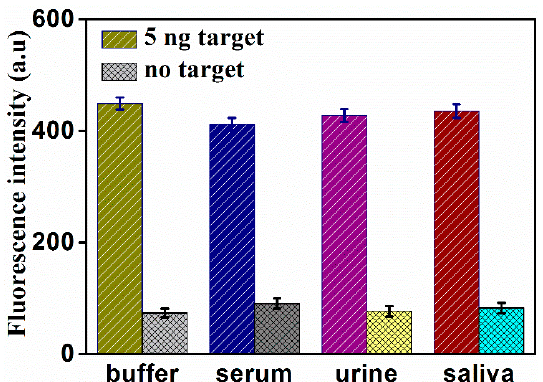
Figure 6. Fluorescence response of the assay for detection of PSA in buffer and various blank biological samples (human serum, urine, and saliva).